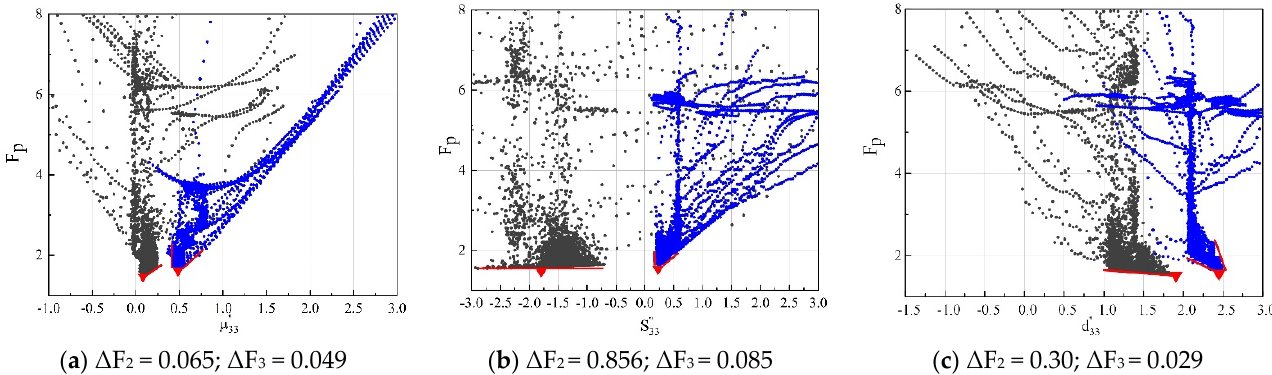
Figure 11. Sensitivities of six parameters in Method 1. Δ F 1 is used to quantify the global sensitivity, which has been defined.